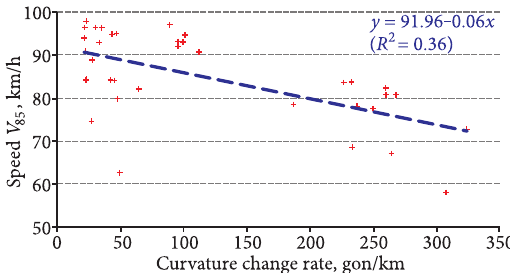
Fig. 10. Illustrative speed model derived from data on the pilot road segment Table 3. Equations of relatively similar speed models Model derived from Czech pilot study